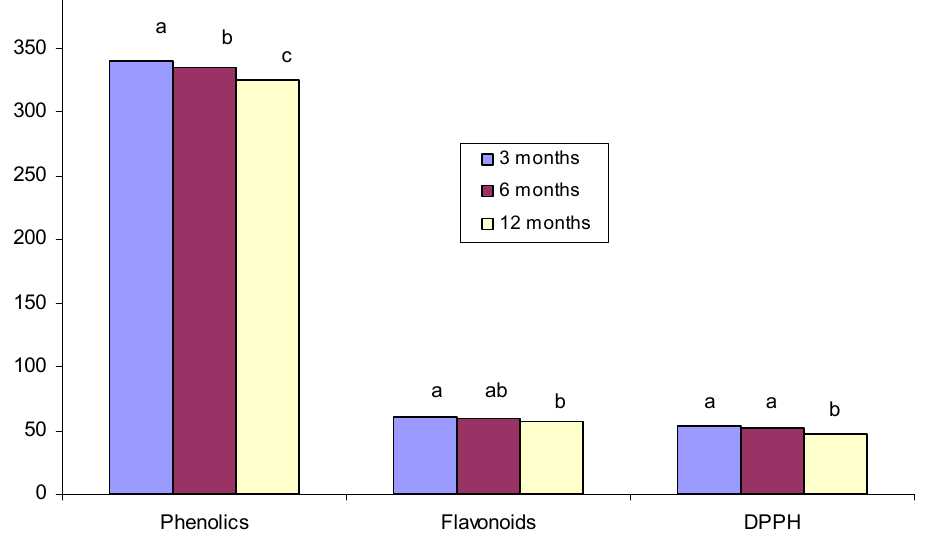
Figure 4. Mean phenolic and flavonoid contents and DPPH free radical-scavenging activities in Tualang honey samples (n = 14) stored in different conditions for three, six or twelve months. Different letters (a, b and c) indicate significant differences ( p <